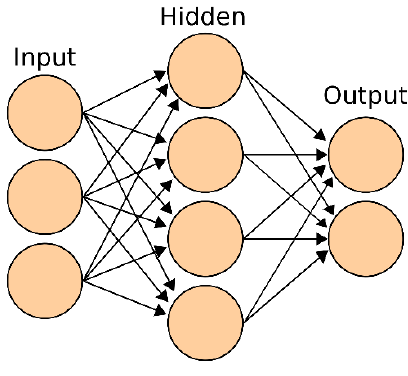
Figure 4. ANN topology.